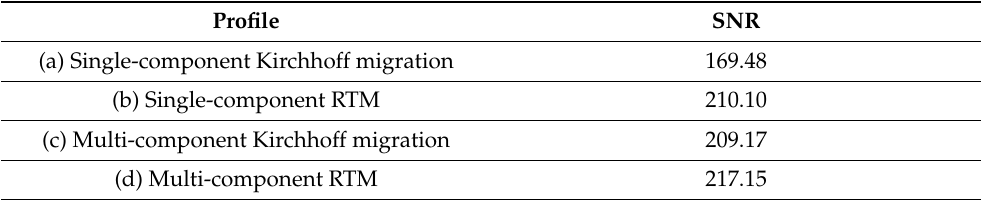
Table 1. SNR of the migration results of the modeled data.